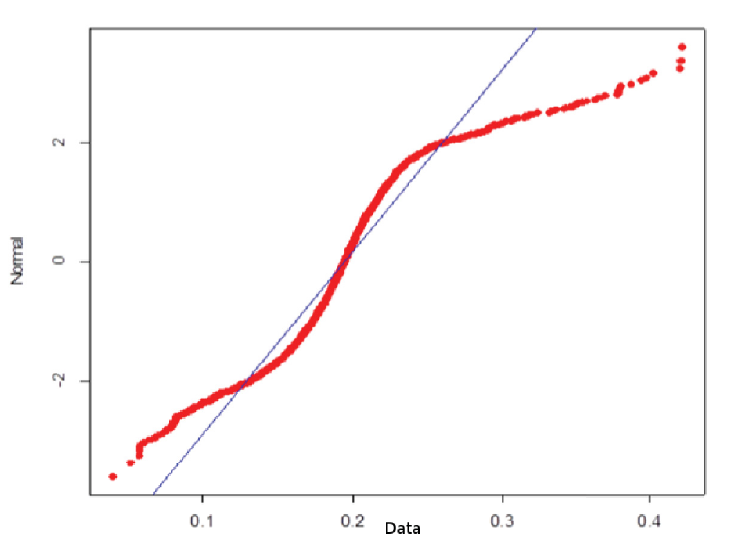
Fig 3. Shapiro-Wilk Normality Test stock rate of return (different types of agents). Source: Own creation.